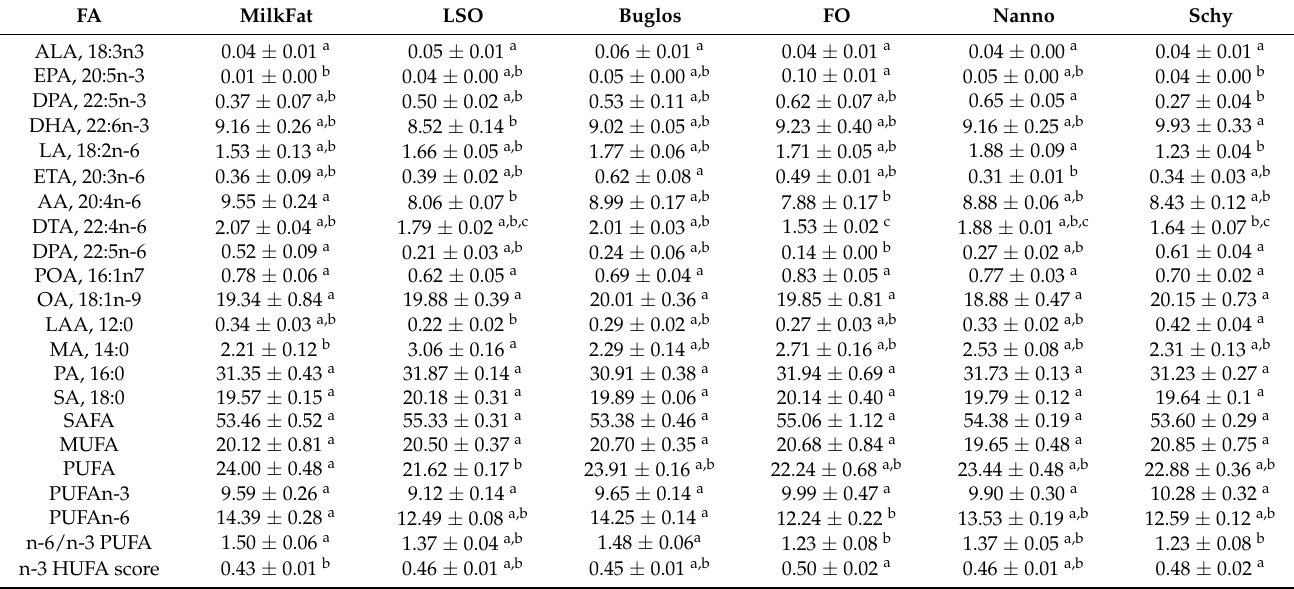
Data represent mean ± SEM for four rats per group and are expressed as % moles/total FA. Values in the same row with different superscript letters are significantly different, p ≤ 0.05 (one-way ANOVA nonparametric measures with Kruskal–Wallis test). ALA, α -linolenic acid; EPA,